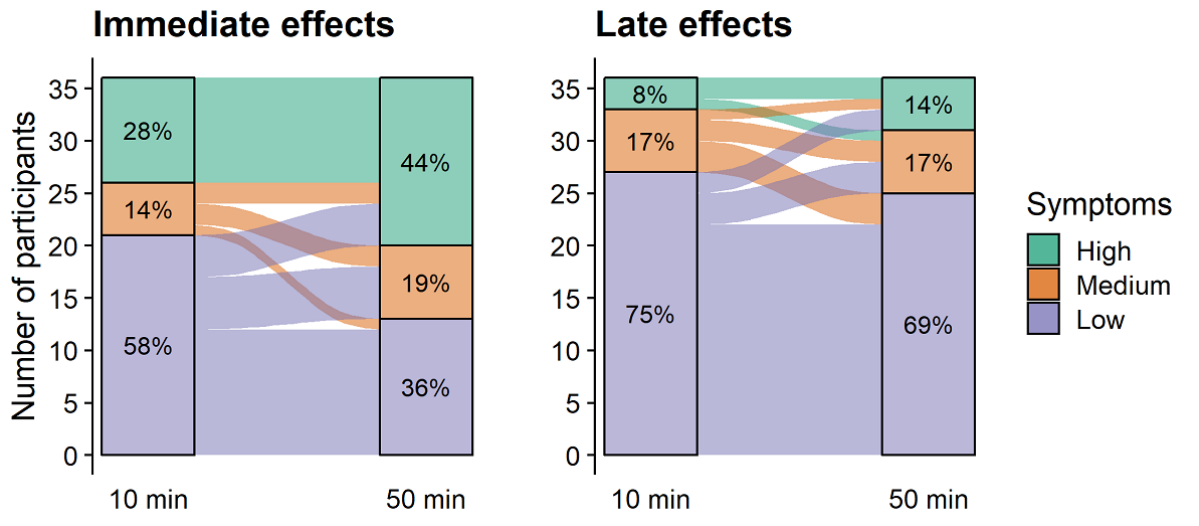
Figure 4. Alluvial plots showing how participants' flow from one virtual reality sickness category to another on the basis of exposure duration and test period. Bars indicate the percentage of participants who are in each of the high, mid, and low virtual reality sickness symptom categories for 10-min and 50-min exposures. Left and right panels show the flow of the categories for the immediate and late test period,